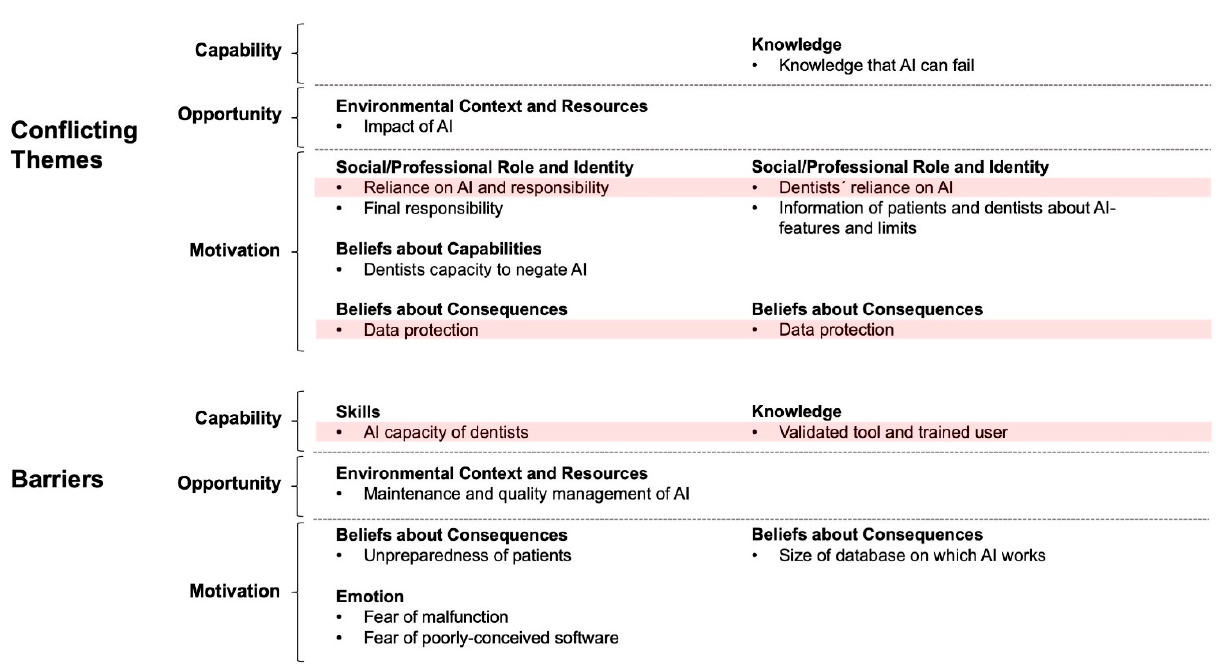
Figure 2. Identified enablers, conflicting themes and barriers for implementation of a new AI-tool in dental X-ray diagnostics. Eight dentists were interviewed, revealing 20 themes for this topic. From five patient interviews, 16 themes were derived. Themes were classified according to the different TDF domains (Knowledge, Environmental Context, Resources, etc.), as well as along the COM-B domains (Capability, Opportunity and Motivation) and as enablers, conflicting themes and barriers. Themes recurring for both dentists and patients are highlighted in pink.